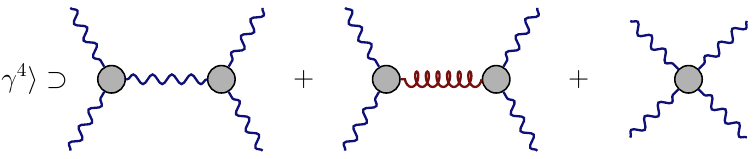
γ 4 from gravitons and partially massless h i T 3 and Σ T 2 coefficients we have already cal- h i h i T 4 coefficient which we have not calculated and h i